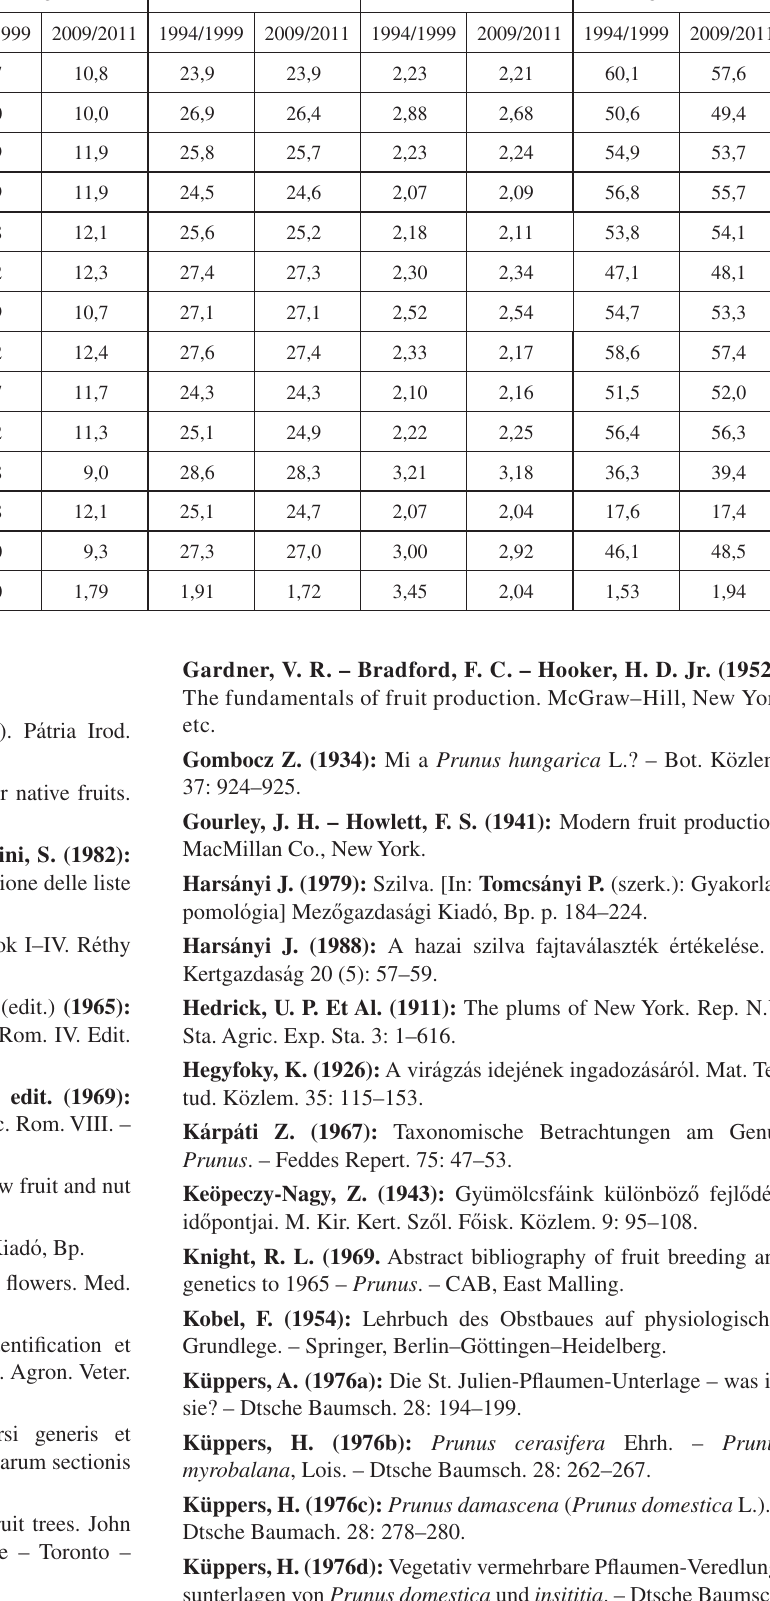
Table 9. Estimation of sexual organs in Prunus taxons (mean) Pistil lenght, CULTIVAR